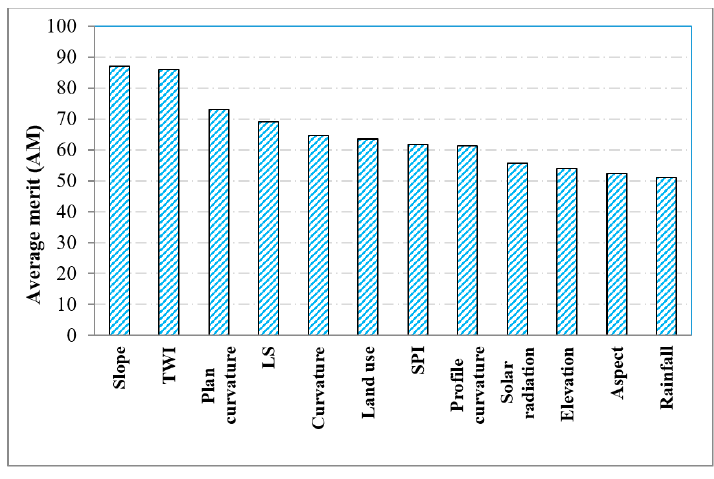
Figure 3. The most significant landslide conditioning factors determined in the modeling phase.